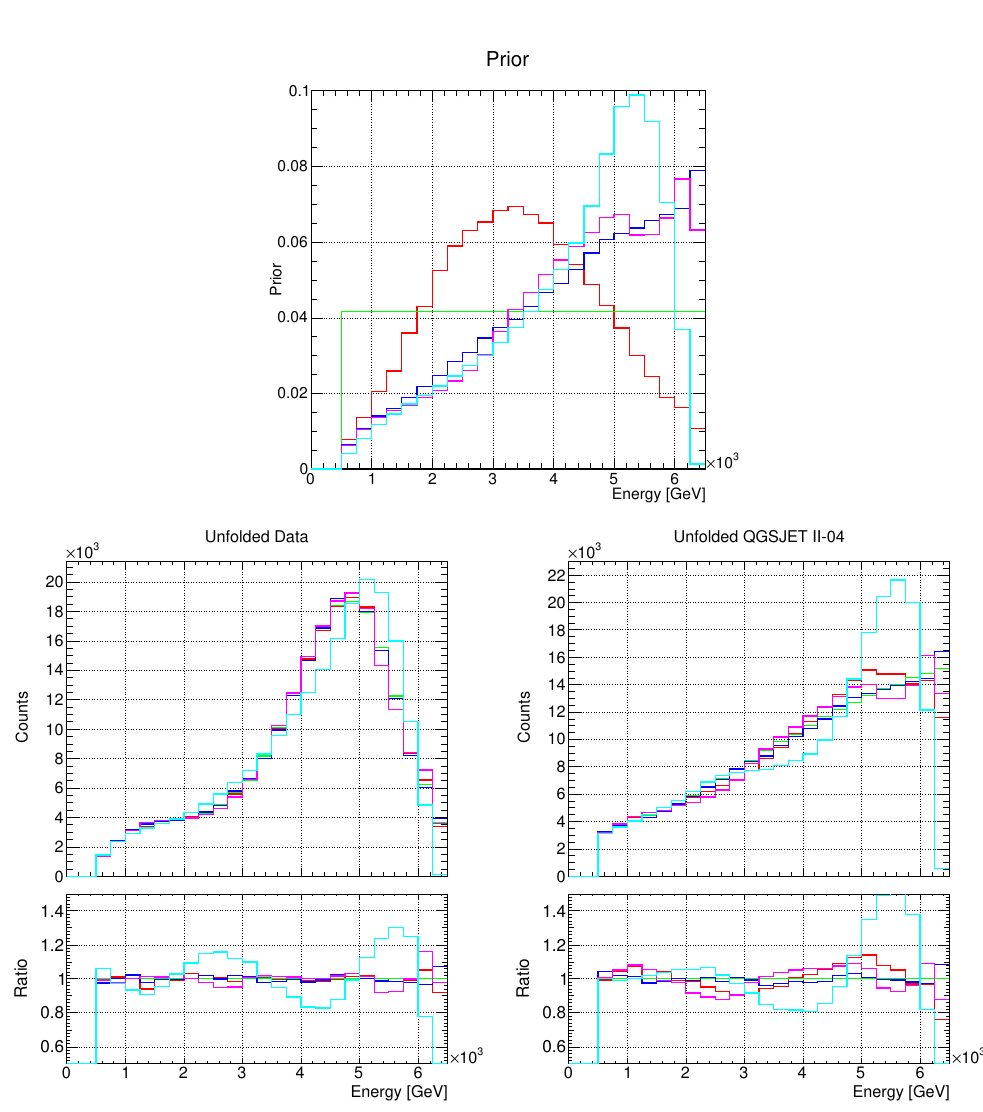
Figure 7 . Top (cid:12)gure shows the di(cid:11)erent priors used for iterative Bayesian unfolding and bottom (cid:12)gures show the unfolded results corresponding to these di(cid:11)erent priors: left is experimental mea- surements, right is QGSJET II-04 simulations. The unfolded results are shown both as absolute value (top) and as the ratio to the spectrum ontained using (cid:13)at prior (bottom). The di(cid:11)erent priors are: (cid:13)at (green), QGSJET II-04 (blue), EPOS-LHC (magenta), DPMJET 3.04 (red), ISR (cyan). The ISR prior was extrapolated applying the method described in reference [30] to the data relative p to p-p collisions at s = 44 : 9 GeV [28, 29]. Note that the ISR prior leads to an unfolded result that is very di(cid:11)erent from the one obtained with the other